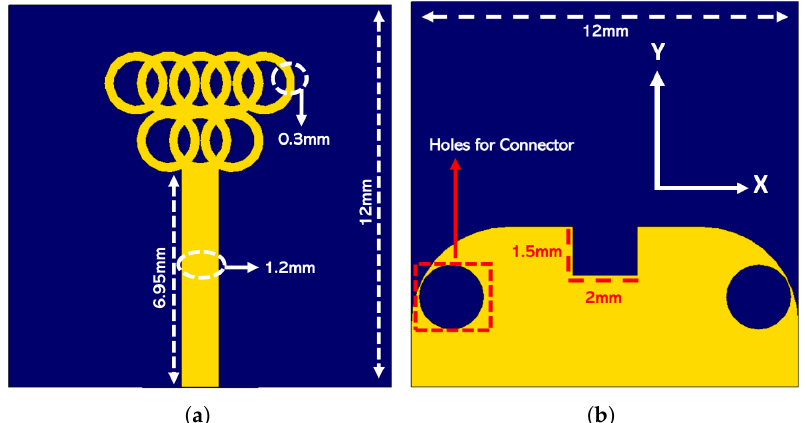
Figure 1. Olympeak antenna ( a ) front and ( b ) back.